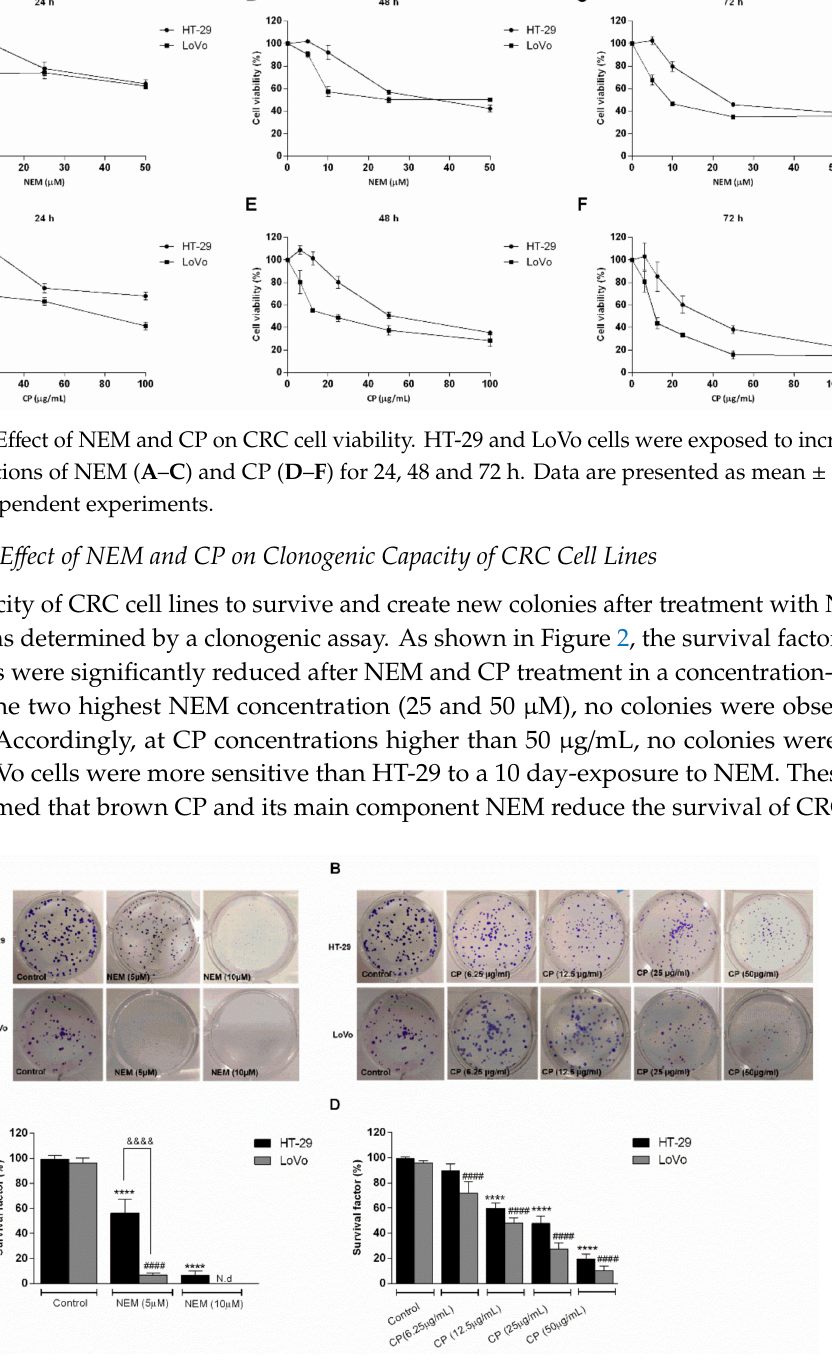
Figure 2. E ff ect of NEM ( A , C ) and CP ( B , D ) on the clonogenic capacity of colorectal cancer (CRC) cells. Magnification: 10 × . Data are expressed as survival factor and represent the mean ± S.D. of three independent experiments. **** p < 0.0001 vs. untreated cells. LoVo cells: #### p < 0.0001 vs. untreated cells. &&&& p < 0.0001 vs the other cell line treated with the same conditions. N.d: not